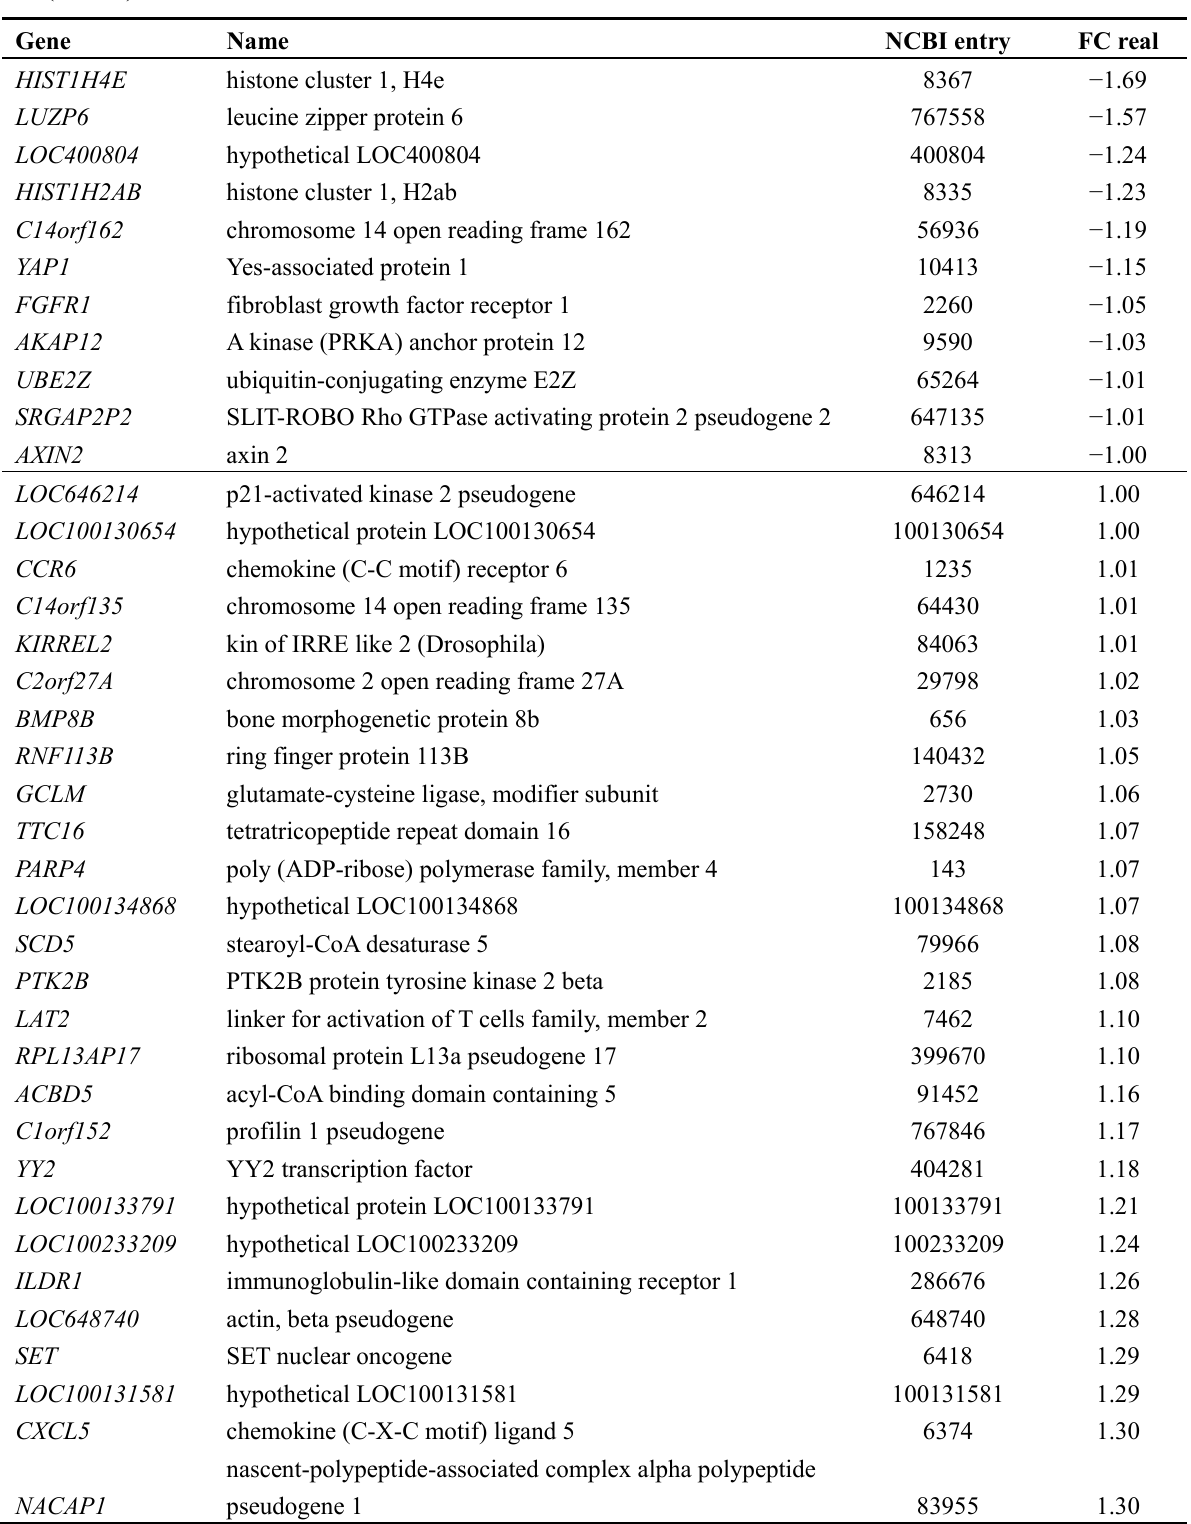
Table 2. Genes altered in NT2 cells induced by paraoxon during the initial stage of RA-induced differentiation of pluripotent cells towards the neural committed progenitor cells. Cells were exposed to 1 µM paraoxon for 4 days in RA-induced differentiation. Data represent the genes linked to altered mRNA levels compared to control (non-exposed) cultures as identified according to the National Center for Biotechnology Information (NCBI)